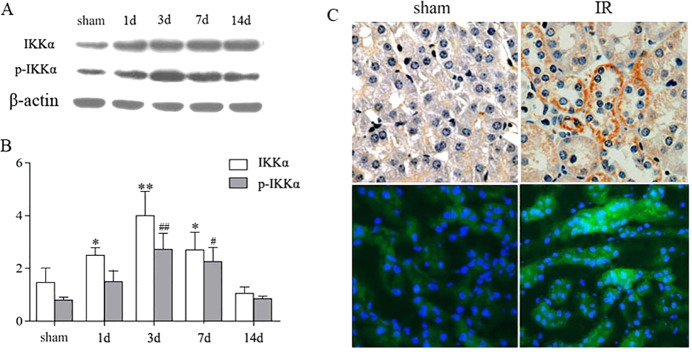
The expression of IKKα on TECs in the repair phase after renal IR injury. C57BL/6 mice underwent unilateral renal pedicle clamping for 45 min, followed by reperfusion. The kidneys were harvested on days 1, 3, 7 and 14, respectively. (A) The expression of IKKα and p-IKKα was analyzed by western blotting. (B) Levels of IKKα in the kidneys after normalization to β-actin. (C) Expression of IKKα by immunohistochemistry (top) and immunofluorescence staining (bottom). Representative images of IKKα staining are distributed in the renal TECs and tubule interstitium. Data are presented as mean±s.d. (n=6 mice). **P<0.01, *P<0.05 versus sham treated for IKKα/β-actin; and ##P<0.01, #P<0.05 versus sham treated for p-IKKα/β-actin.